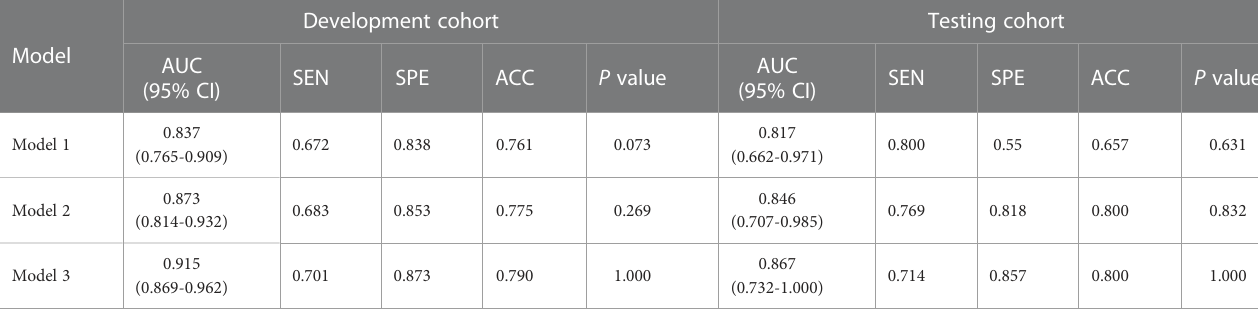
TABLE 5 Predictive performances of the three developed radiomics models.